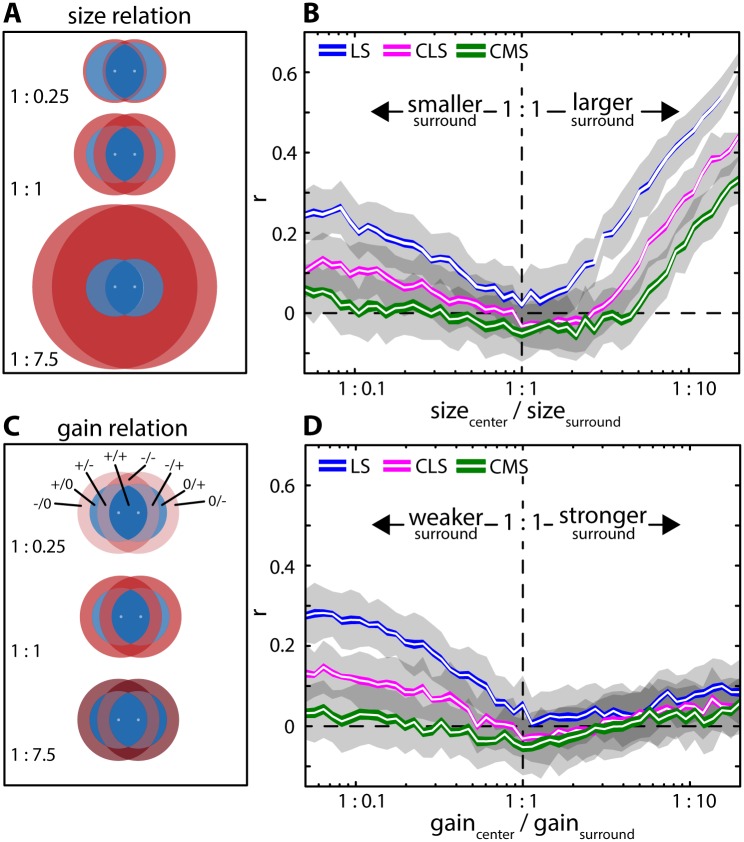
RF center-surround balance shapes correlations.(A) Model including an antagonistic center-surround structure which increased the complexity of the inputs (see Methods for detailed description). Shown are RF centers (blue) and surrounds (red) for three different RF center-surround size values (top: 1: 0.25; middle: 1: 1; bottom: 1: 7.5). In this plot, RF center size and overlap is that of LS as per anatomical data. (B) Correlation coefficients as a function of RF surround relative size for the three ELL maps (blue: LS; magenta: CLS; green: CMS). Differences between the three segments in terms of RF center size and % overlap were modeled according to available anatomical data (see Methods). Shown are the mean (white lines), SEM (colored areas) and STD (gray areas) of spike-count correlations calculated for t = 100 ms. (C) RF centers (blue) and surrounds (red) for three different RF surround gain values (top: 1: 0.25; middle: 1: 1; bottom: 1: 7.5). We separated the areas of RFs interactions into different sub-regions that were denoted by “+” if part of the center, “-”if part of the surround, and “0” if there is no input to a particular pyramidal cell. For example, “+/-”indicates the sub-region consisting of the overlap between the RF center of neuron 1 and the RF surround of neuron 2. (D) Correlation coefficients as a function of RF surround relative gain. Shown are the mean (white lines), SEM (solid areas) and STD (gray areas) for spike-count correlations calculated for t = 100 ms.